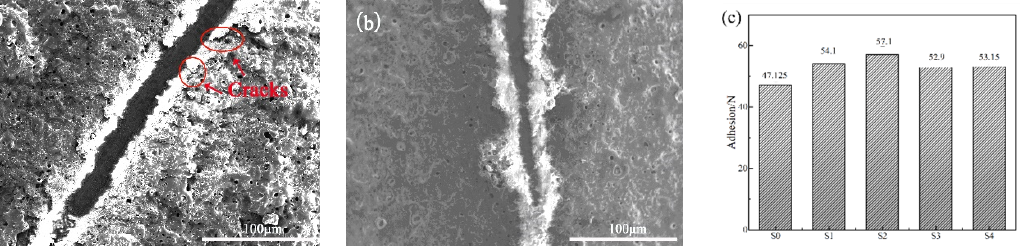
Figure 8. Scratch morphology and adhesion force of the MAO coating. ( a ) Scratch morphology of S0; ( b ) scratch morphology of S2; ( c ) adhesion force.